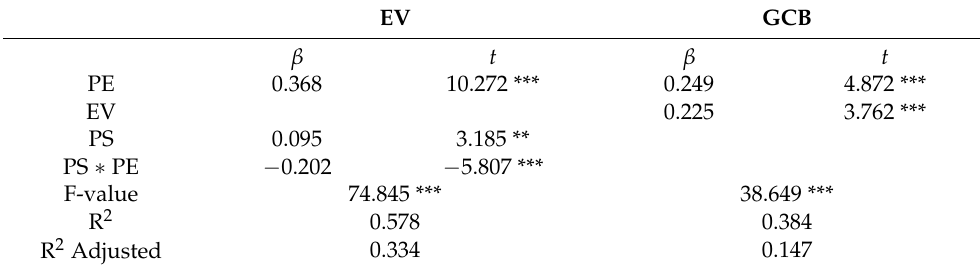
Table 6. Test results of regulatory effect.